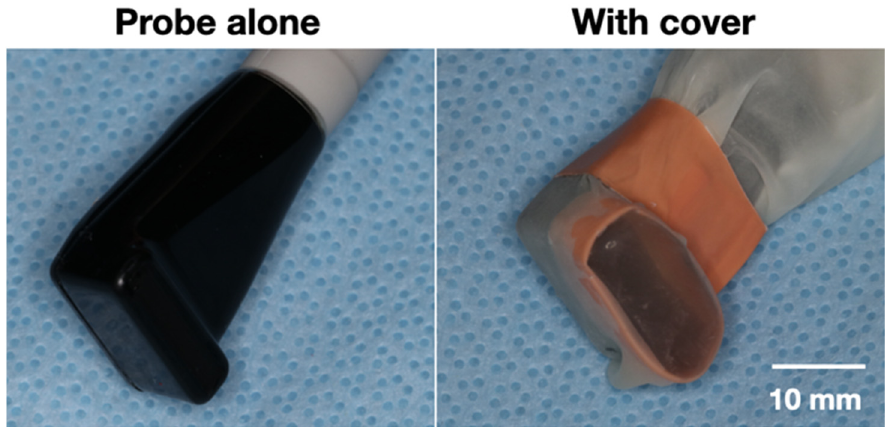
Figure 3. Modern miniature-sized ultrasound probe (transducer) with high frequency (24 MHz).